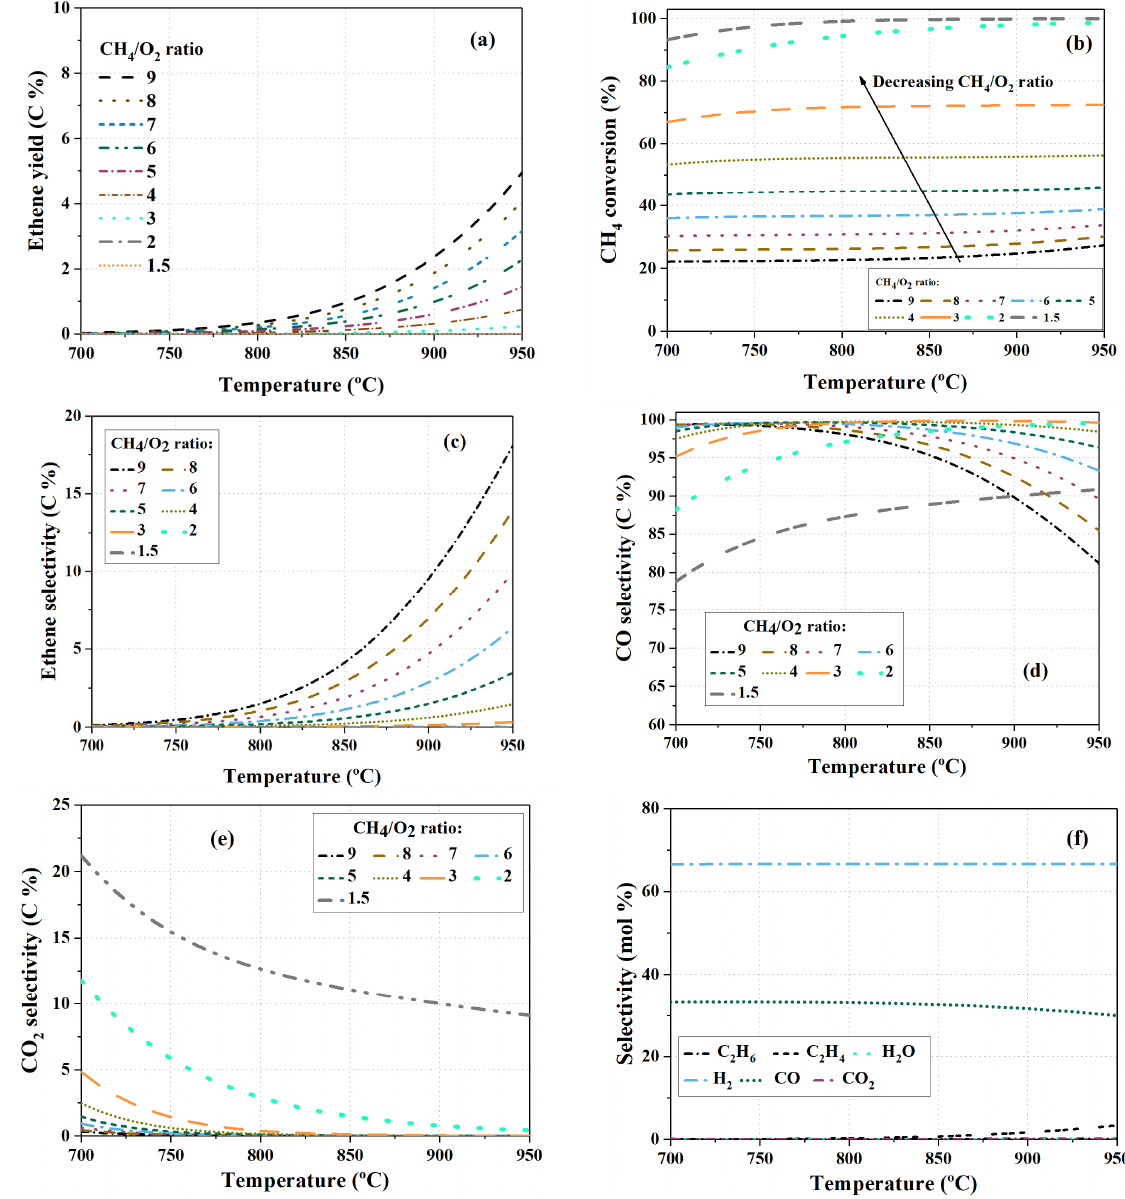
Figure 21. Effect of the CH 4 /O 2 feed ratio and temperature at 1 bar on the ethene yield ( a ), CH 4 conversion ( b ), carbon-based selectivity for C 2 H 4 ( c ), CO ( d ), and CO 2 ( e ), and molar-based selectivity distribution at the CH 4 /O 2 feed molar ratio of 9 ( f ). Feed composition contained CH 4 and O 2 only and was varied while keeping the total number of added mols